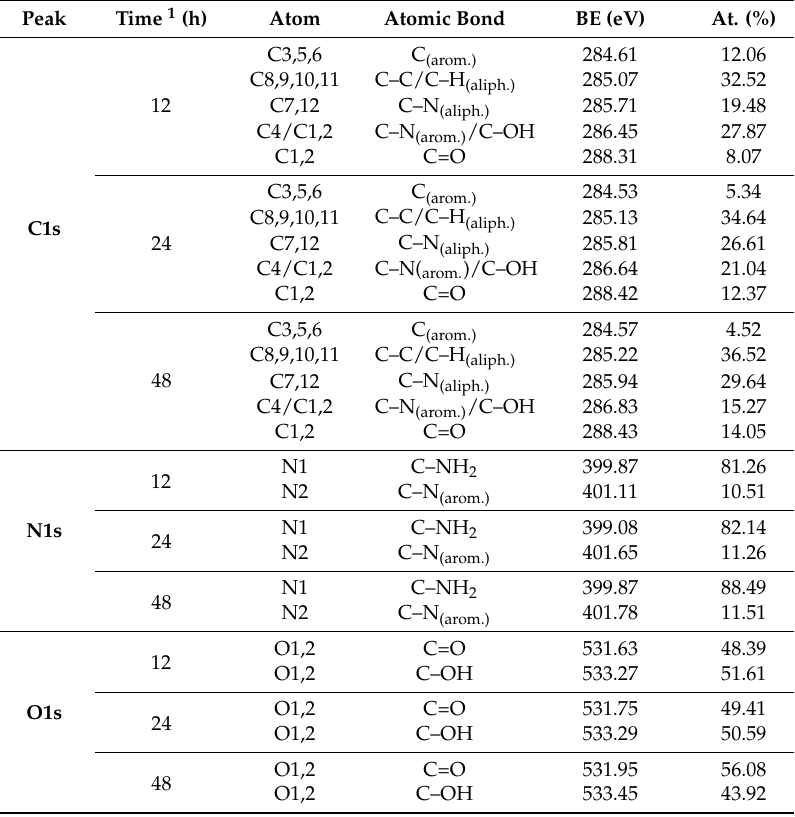
Table 1. Curve-fitting assignments for C1s, N1s and O1s peaks at 12, 24 and 48 h.